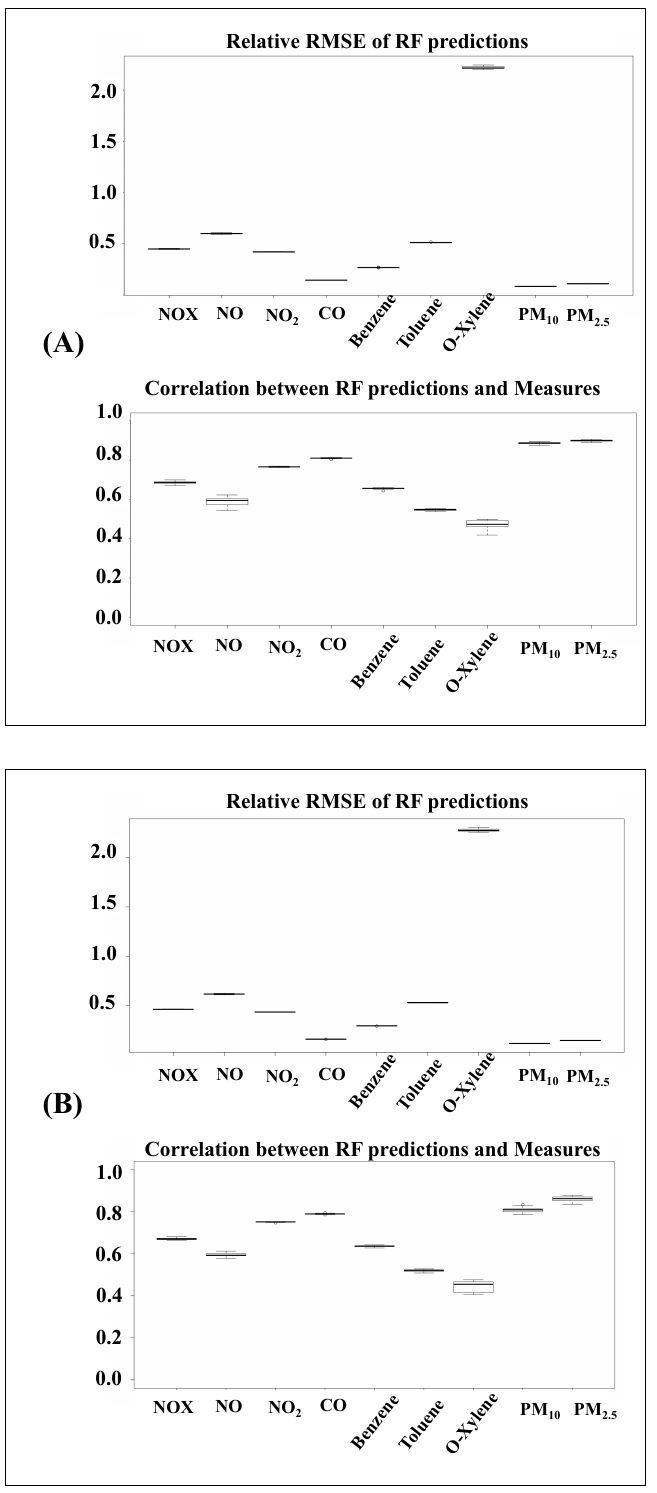
Figure 6. Distributions of the relative RMSE (top) and Pearson’s correlation coefficient (bottom) for each RF model using the WRF prediction for the second day (+48) on the lower resolution domain d01 ( A ) and on the higher resolution domain d02 ( B